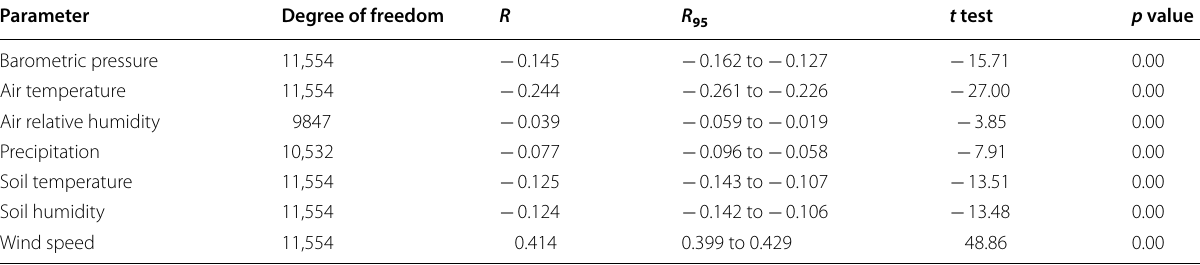
The air temperature data used in this statistical treatment include the interpolated values